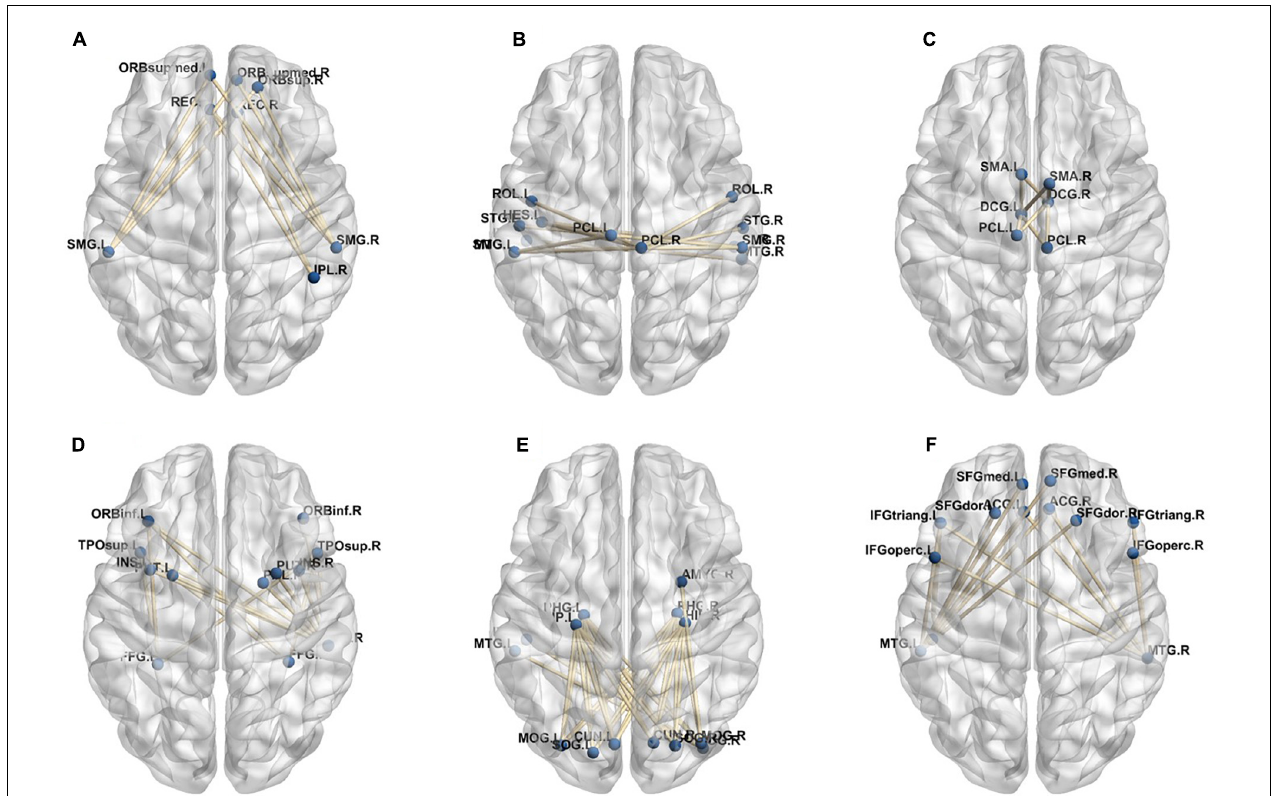
FIGURE 12 | Clusters of low-order FC network (25–30). (A–F) Twenty-fifth to thirtieth